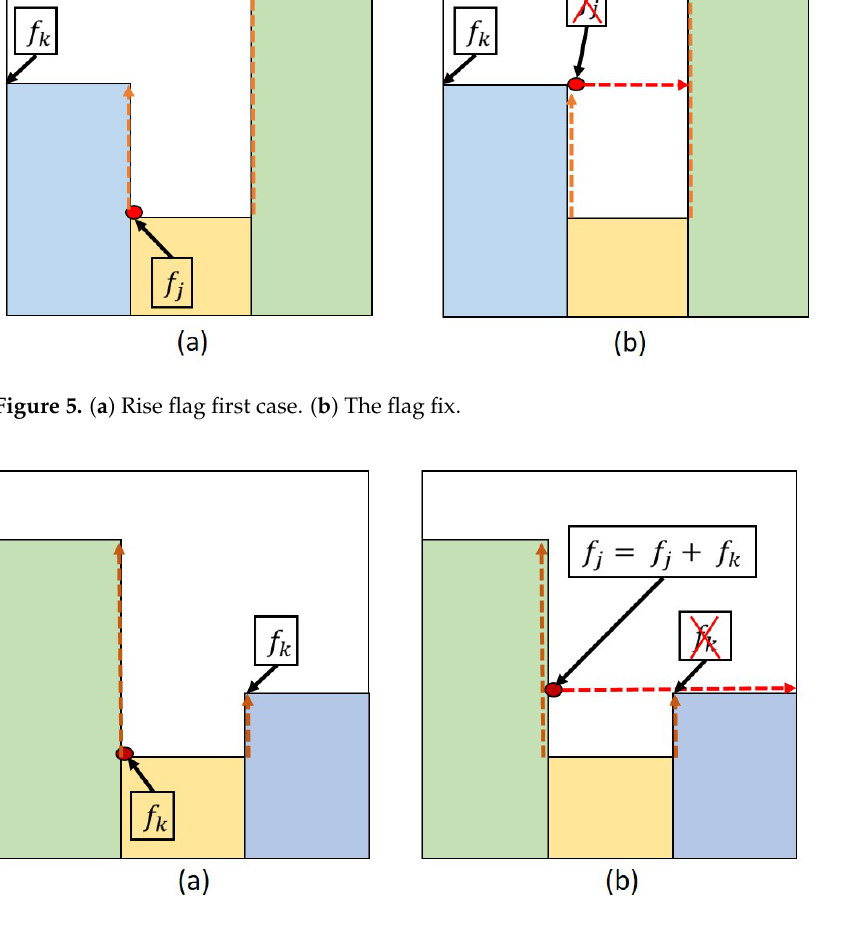
Figure 6. ( a ) Rise flag second case. ( b ) The flag